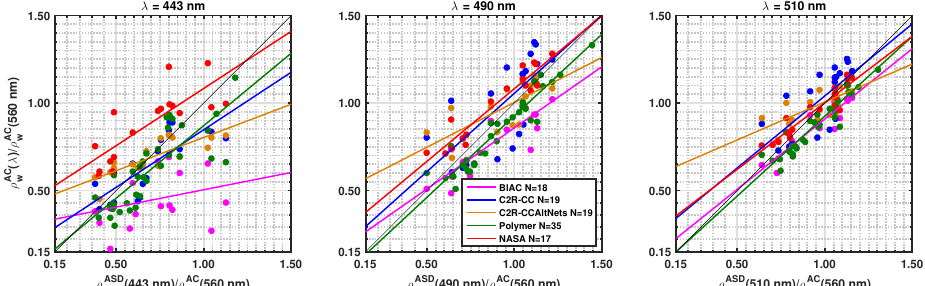
Figure 8. Scatterplots of the AC retrieval and the field measured water-leaving reflectance ratios for 443/560 nm, 490/560 nm, and 510/560 nm wavelengths ratios. In situ OCR ratios ( ρ ASD w ( λ ) / ρ ASD w (560 nm)) are represented in the x-axis and the ACs retrieved ratios ( ρ AC w ( λ ) / ρ AC w (560 nm)) in the y-axis. The color code is similar to that in Figure 3, and the number of match-ups is provided in the text box of the middle